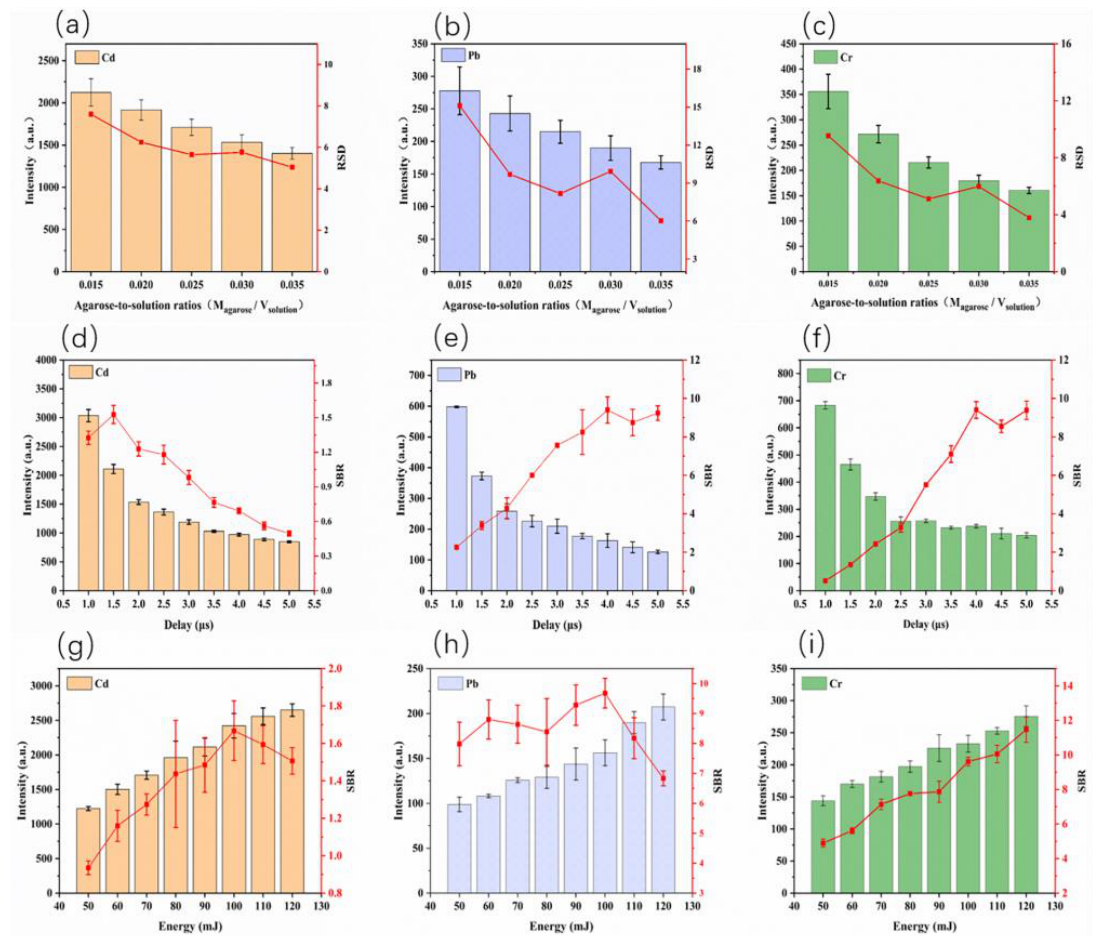
Figure 4. ( a – c ) Effects of the agarose-to-solution ratio (M agarose /V solution ) on the spectral intensity and RSD (red line) in the range of 0.015–0.035 (delay time: 2.0 μs and laser pulse energy: 90 mJ). ( d – f ) Effects of the delay time on the spectral intensity and SBR (red line) in the range of 1–5 μs (agarose-to-solution ratio M agarose /V solution : 0.025 and laser pulse energy: 90 mJ). ( g – i ) Effects of the laser pulse energy on the spectral intensity and SBR (red line) in the range of 50–120 mJ (agarose-to-solution ratio M agarose /V solution : 0.025, delay time: 1.5 μs for Cd, and delay time: 4.0 μs for Pb and Cr). The error bars are the standard deviations of the three parallel samples.